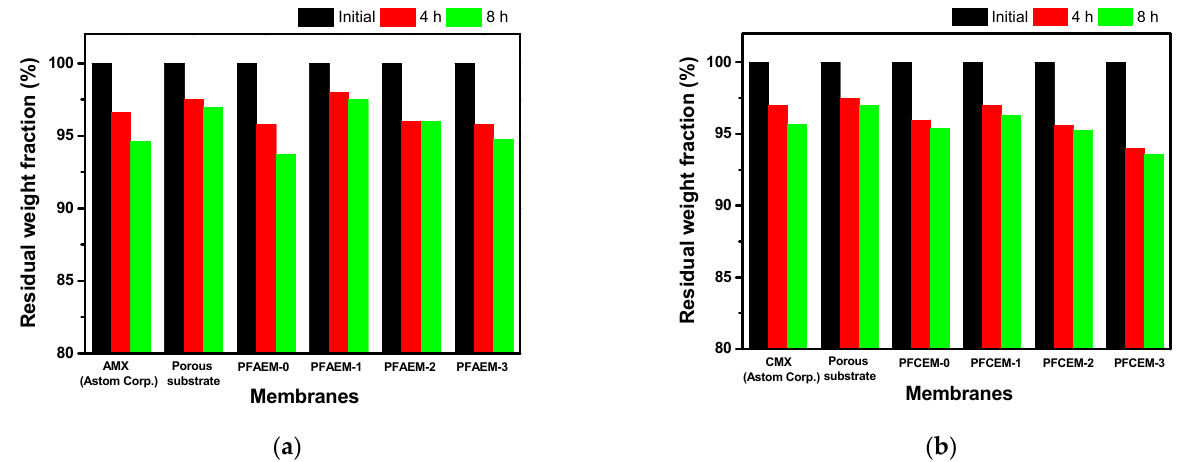
Figure 8. Time course changes in residual weight fraction during the Fenton oxidation test of ( a ) AEMs and ( b ) CEMs.